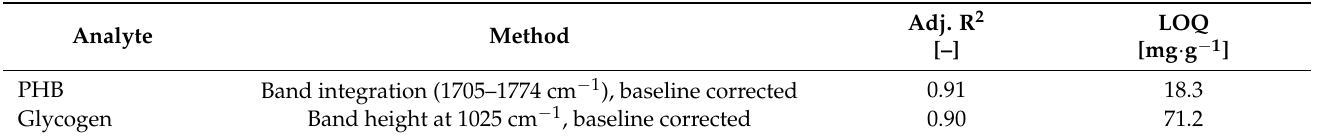
Table 1. Calibration results for PHB and glycogen in situ quantification.